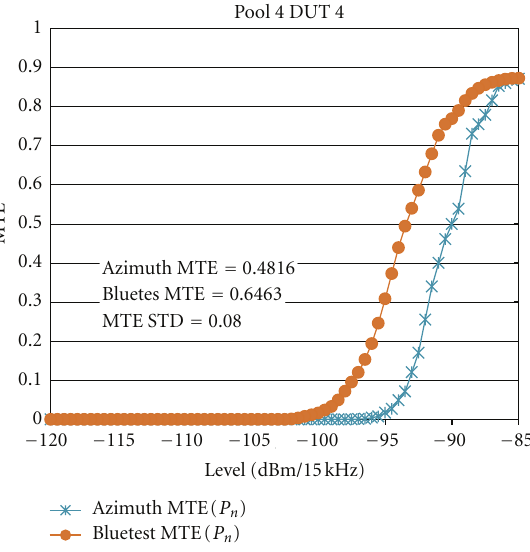
Figure 4: MTE for Pool 4 with the RC methodology.